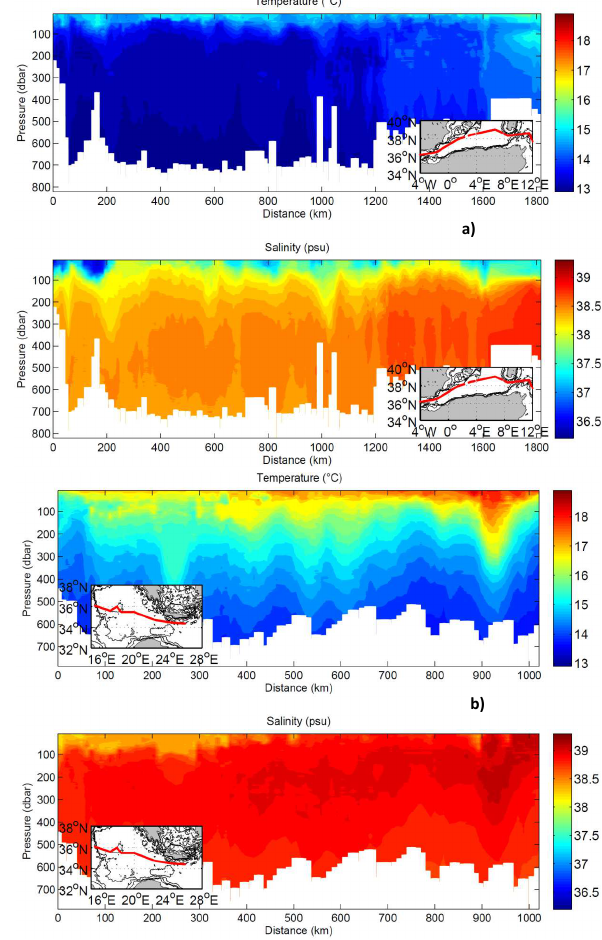
Figure 2. Temperature and salinity distribution along a west–east section through (a) the western Mediterranean Sea and (b) the east- ern Mediterranean Sea. Data are recorded by an underway CTD. Inner panels show the location of UCTD stations. White areas: data are out of instrument